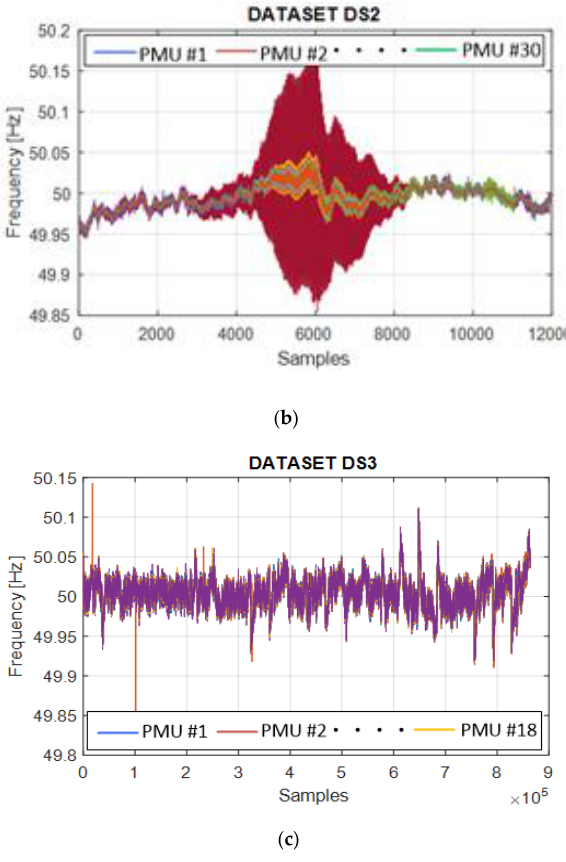
Figure 4. Overview of the data contained in the considered three datasets: ( a ) DS1: oscillatory event #1, ( b ) DS2: oscillatory event #2, ( c ) DS3: 24 h frequency recordings from nominal or “ambient” grid operation.